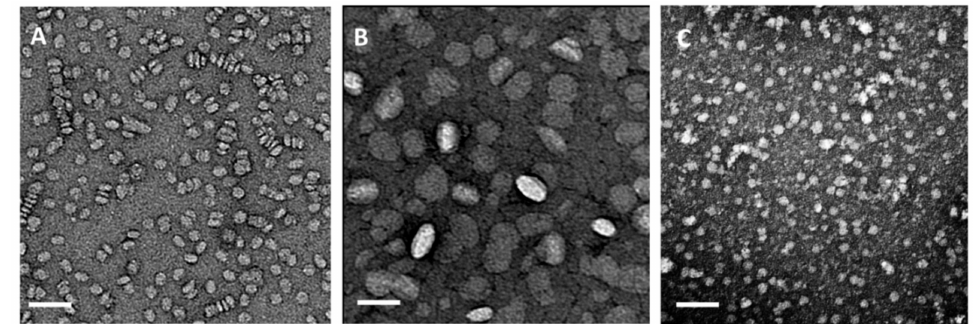
Figure 5. Negative staining transmission electron microscopic (TEM) images of HDL particles. ( A ) rHDL particles reconstituted from dimyristoyl-phosphatidylcholine (DMPC) (8% cholesterol) and full length apo-AI at a molar ratio of 80:1 lipid:protein. The particles are about 10 nm in diameter and discoidal in shape. The circular shapes present nanodiscs viewed from the top. Likewise, stacked nanodiscs resembling “rouleaux” formations are visible. ( B ) rHDL particles assembled from DMPC (8% cholesterol) and apo-AI peptidomimetics (4F) at a molar ratio of 40:1 lipid to peptide. The nanoparticles are larger (about 25–30 nm) and seem to be ellipsoidal in shape; ( C ) HDL particles isolated from human plasma are spherical with particles sizes in the range from 8 nm to 14 nm (unpublished data). The bar represents 50